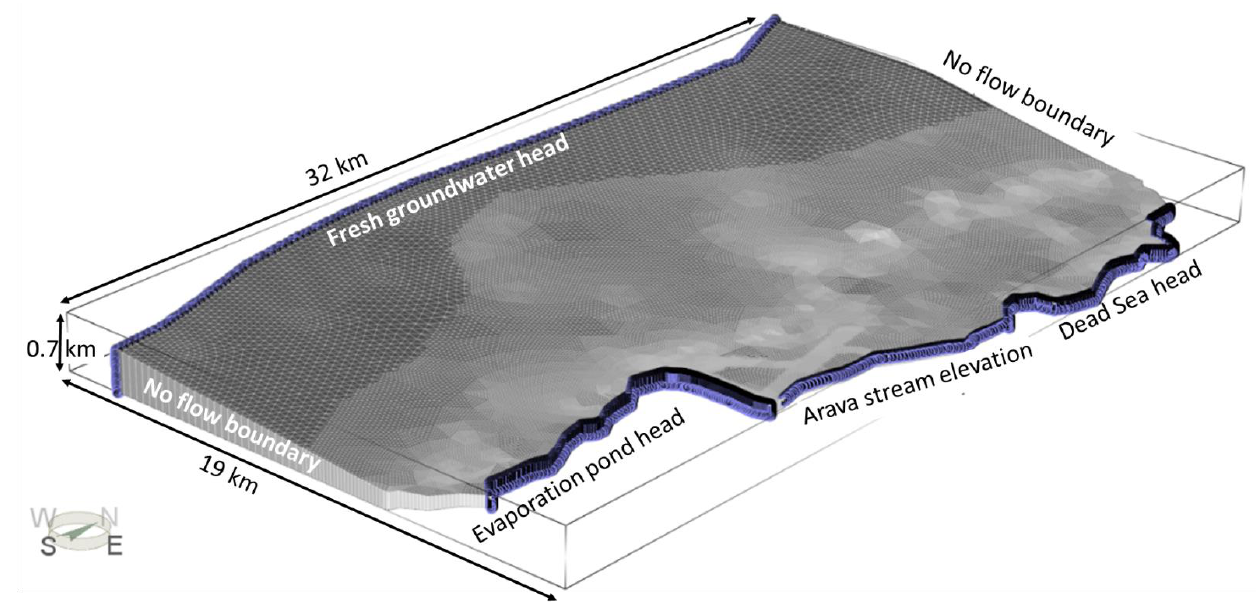
Figure 5. Discretization of the modeled domain. Constant head boundary conditions, which are marked by purple circles, are defined (for each period step) at the evaporation ponds, the Arava stream, the Dead Sea and the western side.